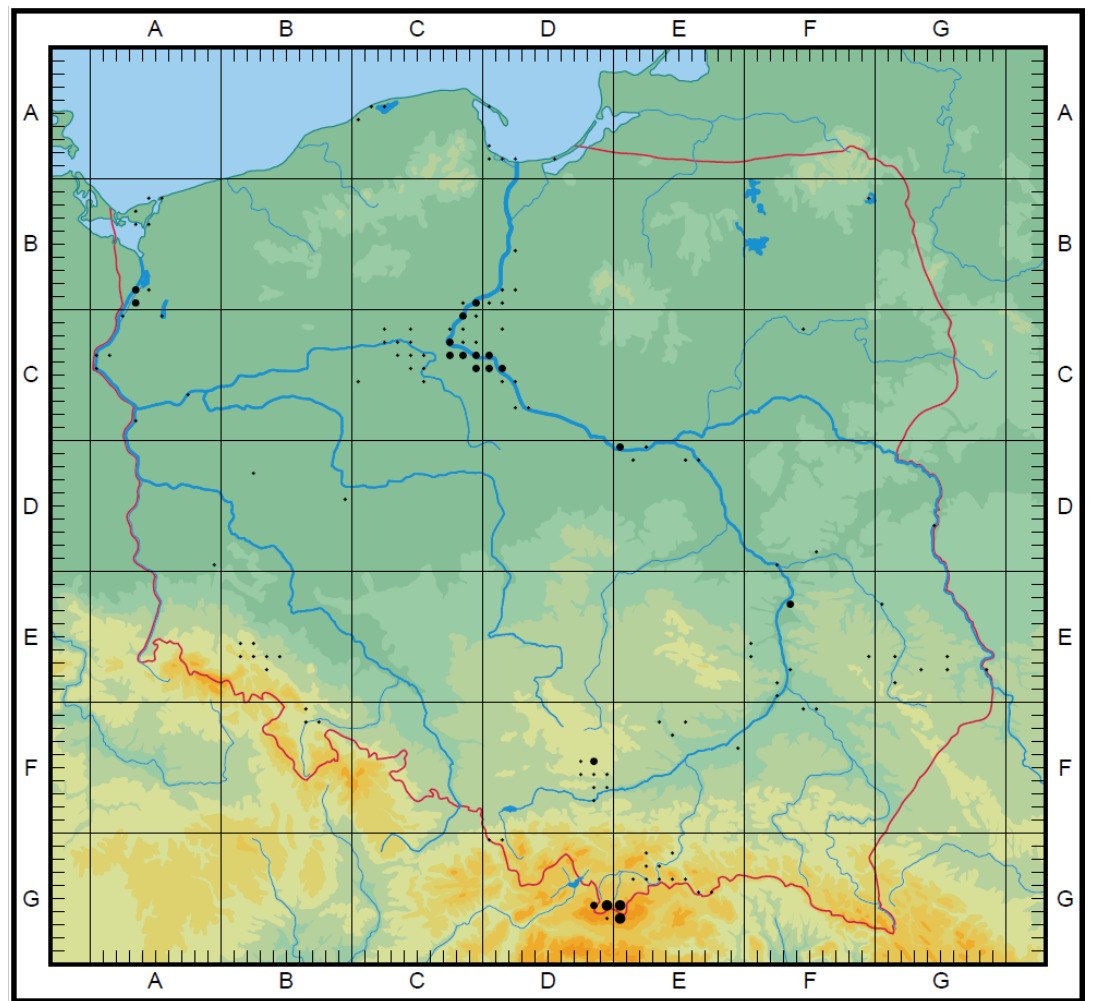
Figure 3. Endemic species of crop wild relatives of the Poaceae family in Poland (map). Rare and threatened grass species from the Polish and European Red Data List and Book [36–39] are to be found chiefly in large river valleys (Figure 4). Endangered and rare species occurring in situ represent 29% of all crop wild relative grasses.